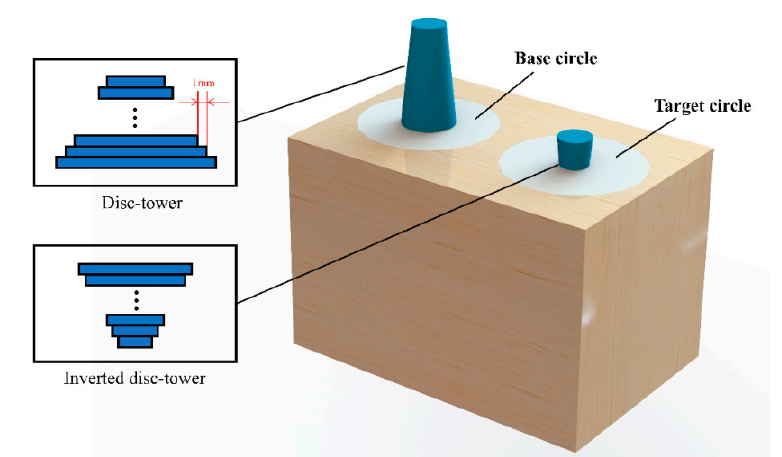
Figure 3. Outline of the disk-tower